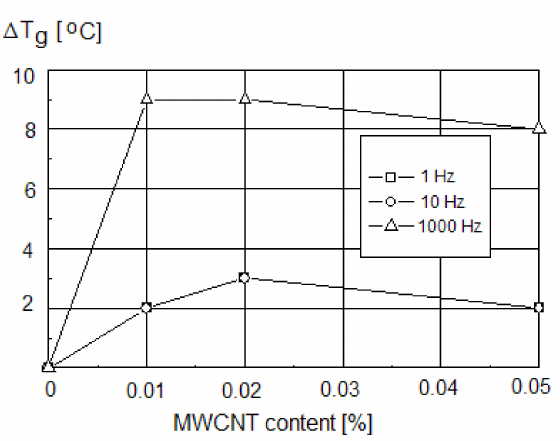
Figure 4. The changes in Tg of PVC nanocomposites at different measurement frequencies as a function of CNT content